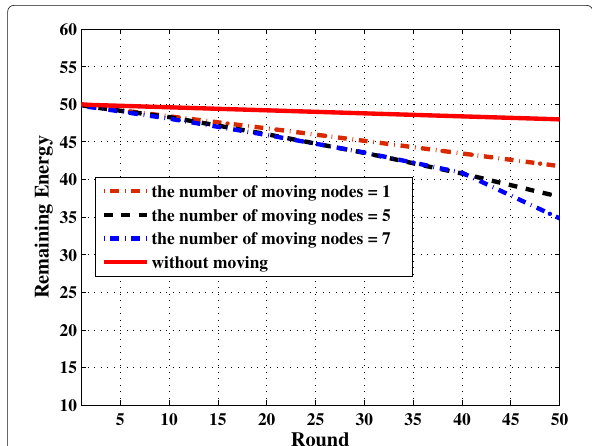
Fig. 2 The relation between remaining energy and the number of rounds